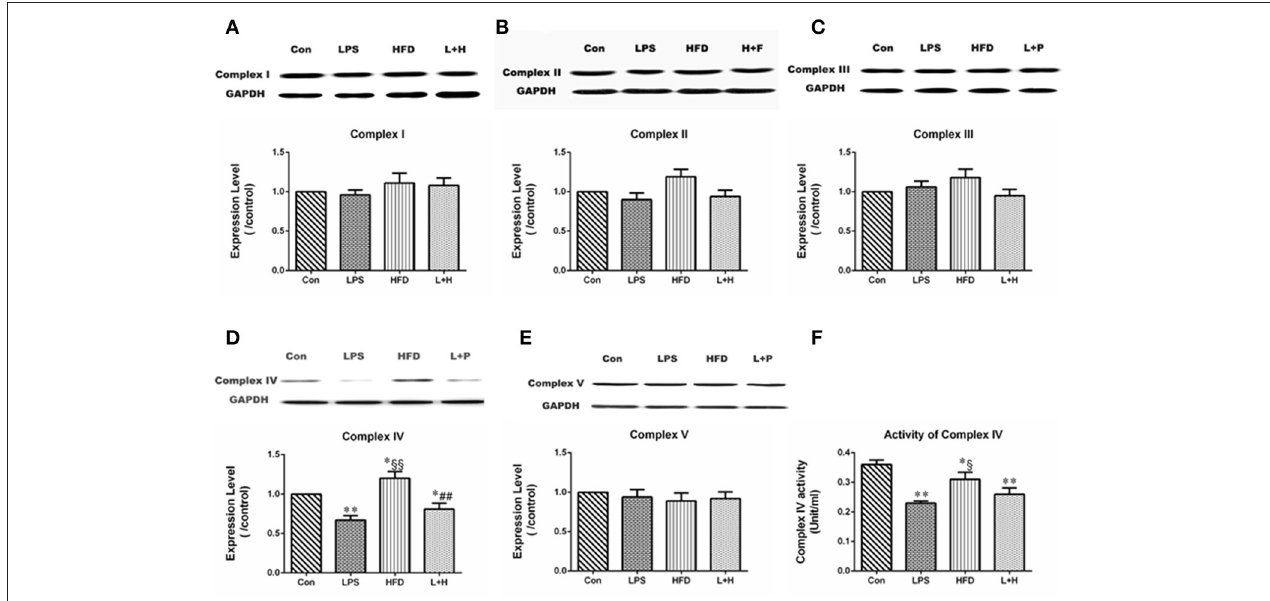
FIGURE 7 | The alterations in mitochondrial respiratory complex proteins in 8-week-old offspring rats. protein expression of mitochondrial respiratory complex I (A) , II (B) , III (C) , IV (D) , and V (E) . The activity of mitochondrial respiratory complex protein IV (F) . The data are presented as the mean ± SEM. n = 6 in each group. * P < 0.05, ** P < 0.01 vs. control, § P < 0.05, §§ P < 0.01 vs. LPS group, ## P < 0.01 vs. HFD group (One-way ANOVA). Con group, male offspring rats treated with prenatal saline and postnatal normal diet from 4 to 8 weeks old; LPS group, male offspring rats treated with prenatal LPS and postnatal normal diet from 4 to 8